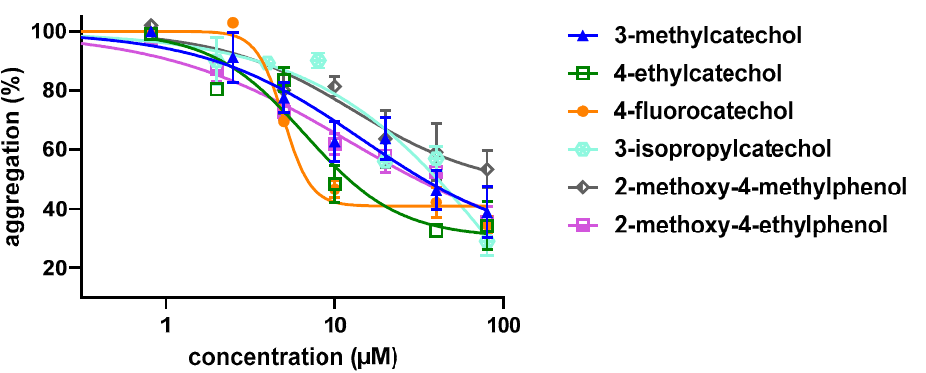
Figure 4. Cytotoxicity of All the Compounds was Tested in MCF7/S0.5 Breast Cancer Cell Line. All